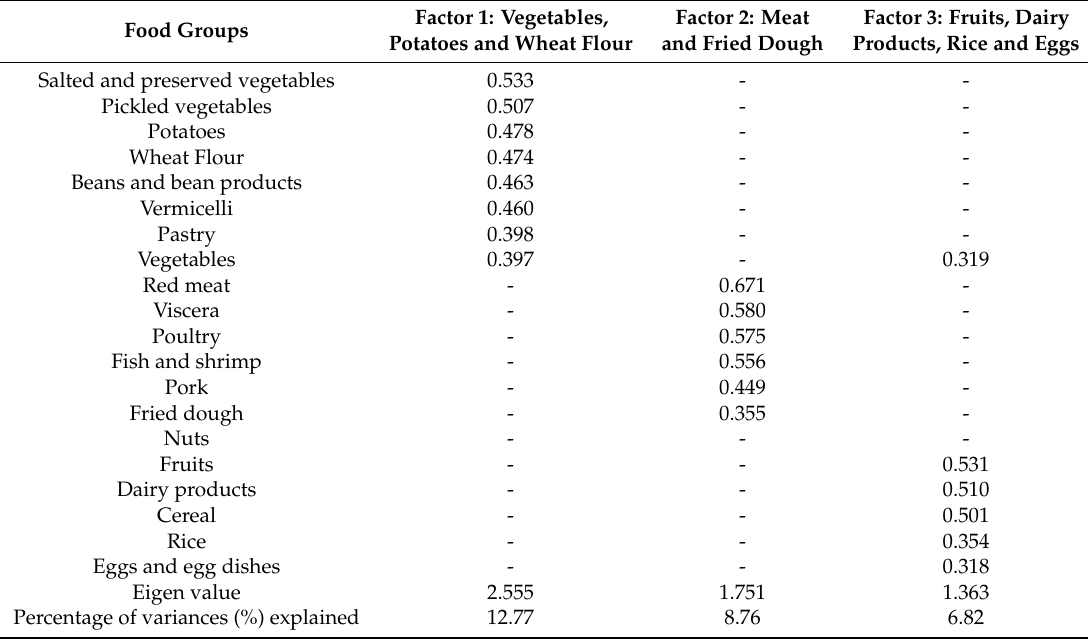
Table 3. Factors and factor loadings derived from FFQ among Chinese coal men *.